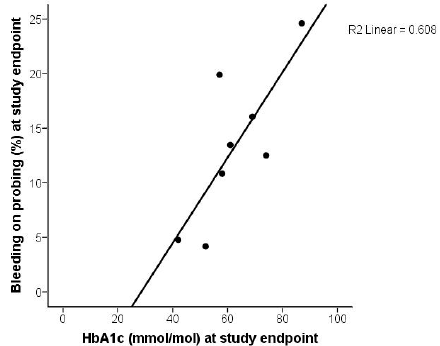
Figure 4. Scatterplot diagram illustrating the relationships between bleeding on probing (BOP; %) and levels of HbA1c (mmol/mol) at study endpoint.